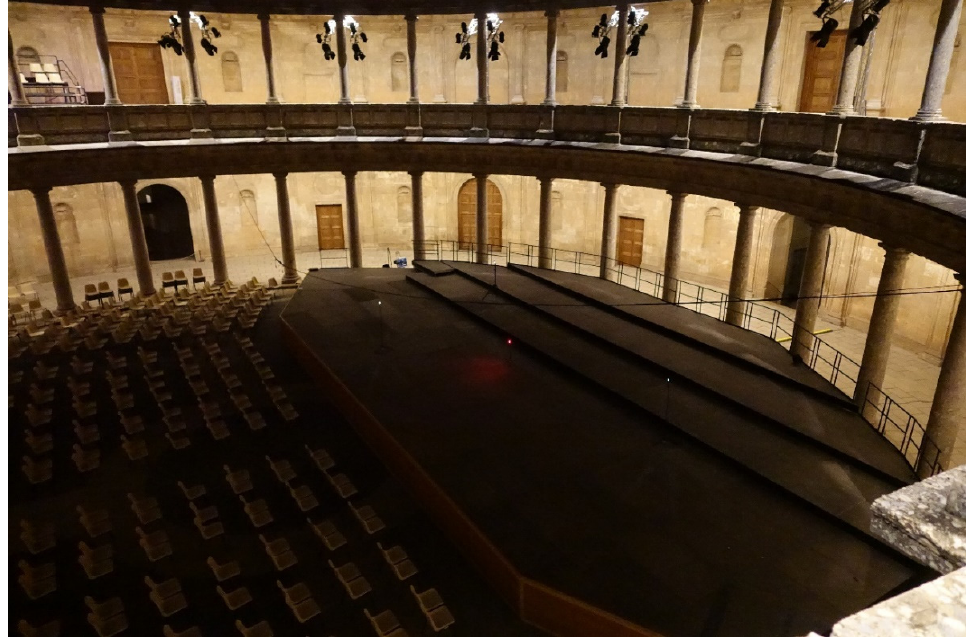
Figure 4. The stage during the measurement campaign.